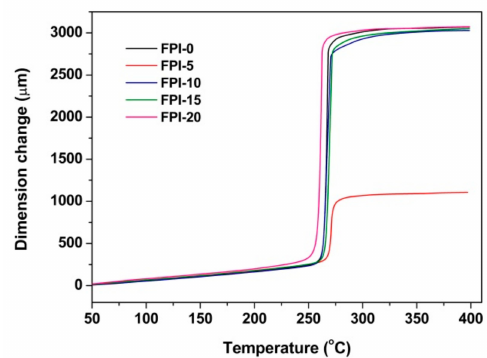
Figure 9. Thermo-mechanical analysis (TMA) curves FPI-TSP films at a heating rate of 10 ◦ C / min under nitrogen flow.